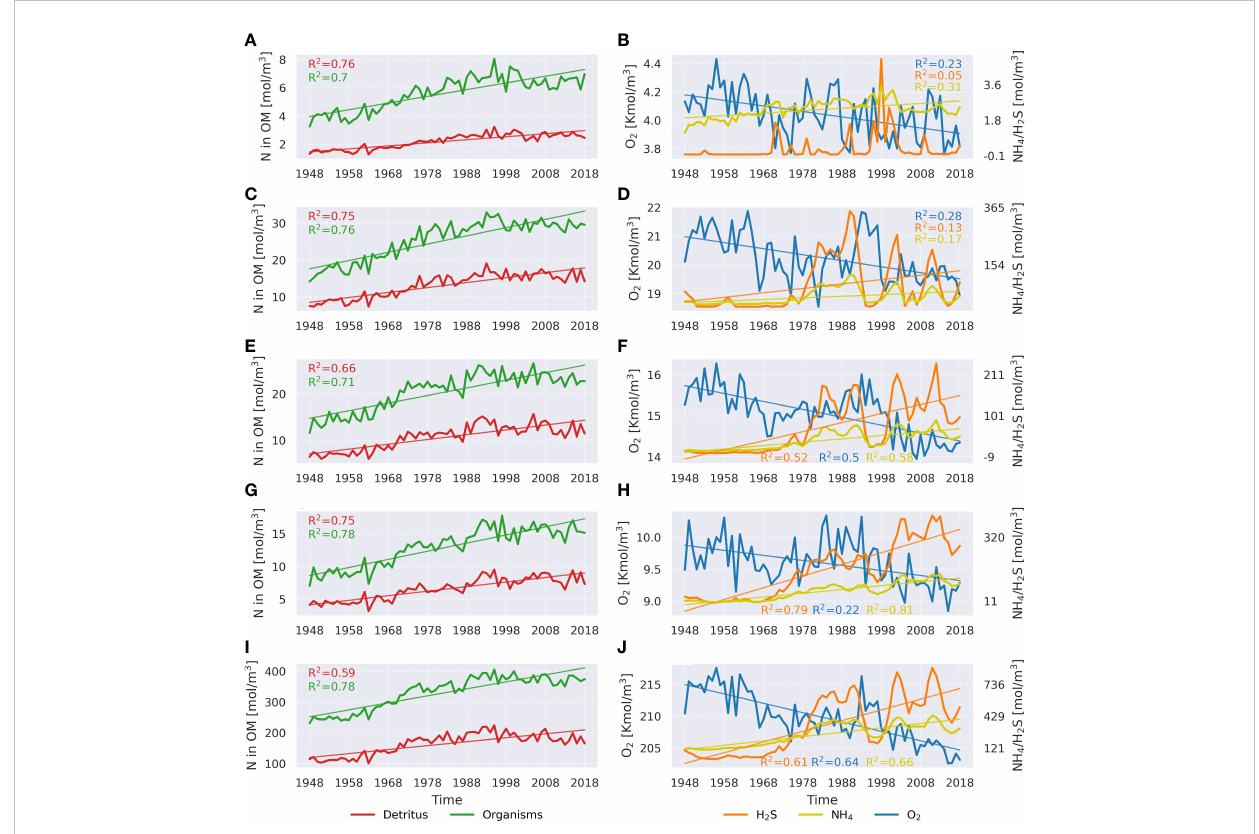
FIGURE 10 Linear trends of some important variables actively participating in oxygen and hydrogen sul fi de dynamics. Left panels depict detritus concentration and concentration of living organisms (phytoplankton and zooplankton) integrated over the whole water column and all sub-basins: the Bornholm Basin (A, B) , the eastern Gotland Basin (C, D) , the northern Gotland Basin (E, F) , the western Gotland Basin (G, H) , and the whole central Baltic Sea (I, J) . All variables are represented by nitrogen in organic matter (N in OM). Right panels show the dynamics of oxygen, hydrogen sul fi de, and ammonium. Only signi fi cant linear trends (p<0.05) are